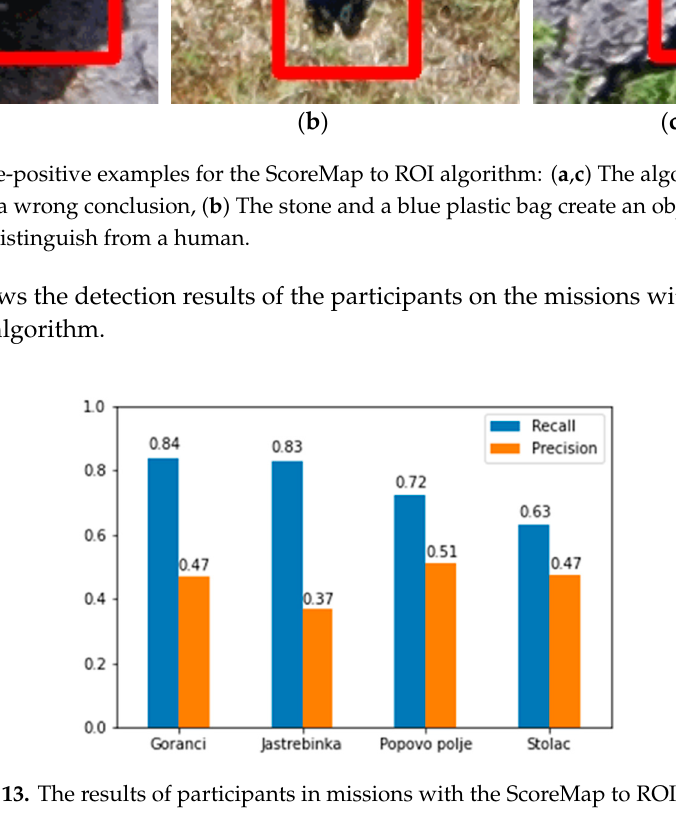
Figure 13. The results of participants in missions with the ScoreMap to ROI support.